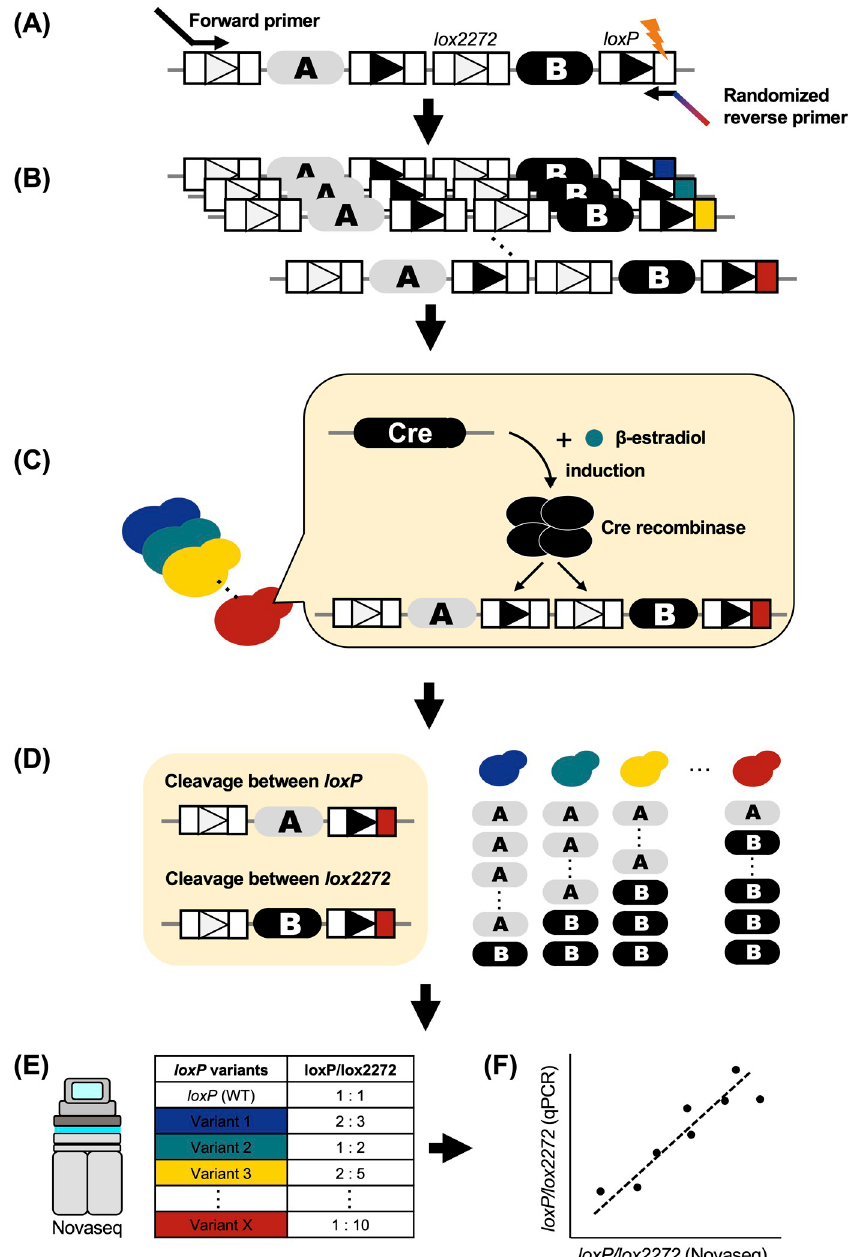
Fig 2. Workflow of this research. Our workflow was divided into six steps. (A,B) Mutagenesis by PCR. We mutagenized one of the RBEs of the loxP sequence and established a library of mutant loxP sequences. (C) Transformation and Cre induction. The library of mutant loxP sequences was transformed into Saccharomyces cerevisiae and Cre was induced. (D) Extraction. After Cre induction, we extracted a library of mutant loxP sequences from S. cerevisiae. (E) Analysis. We analyzed the excision rate of the mutant loxP sequences by Novaseq. (F) Validation. We quantified the excision rate of loxP variants by qPCR, to validate the results of the Illumina sequencing